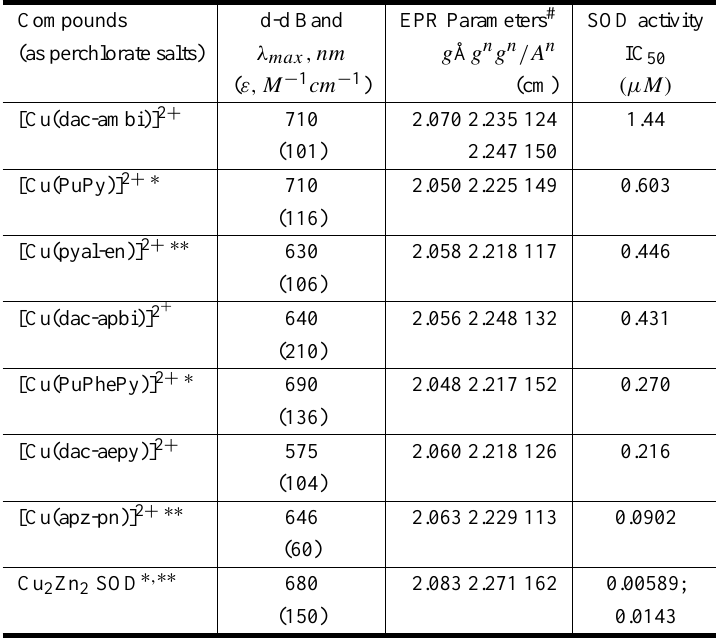
Spectroscopic Parameters and SOD Activity of Some Diimine-Copper(II) Complexes, compared to that of native Cu 2 Zn 2